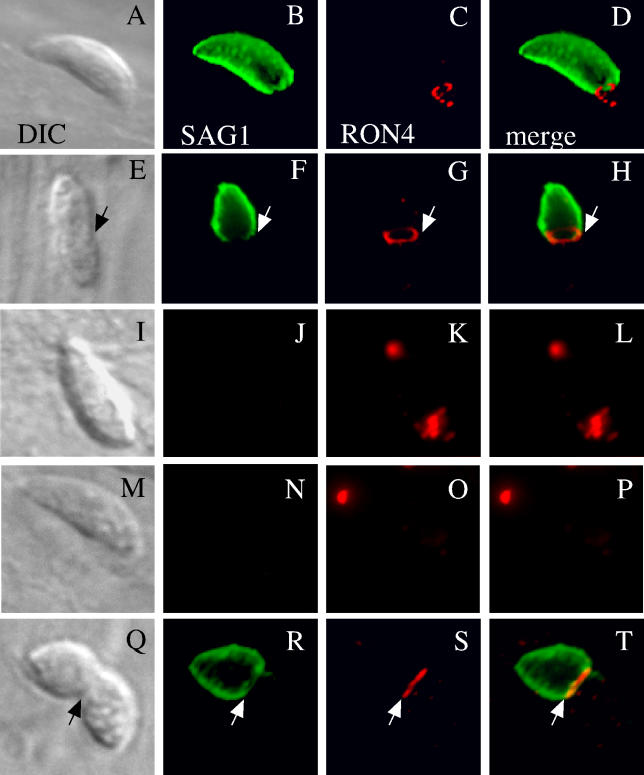
Localization of RON4 During InvasionTachyzoites were allowed to invade following a potassium shift as described in the text. DIC (A, E, I, M, and Q) and deconvolution IIF were then used to image formaldehyde-fixed parasites as described in Figure 3. The images presented are extended focus projections through ten 0.2-μm sections. Prior to detergent permeabilization, SAG1 was detected with the mAb DG52 followed by goat anti-mouse antiserum conjugated to FITC (green) (B, F, J, N, and R). RON4 detection was with rabbit antisera raised to recombinant RON4 and Texas red-conjugated goat-anti-rabbit antibody; this was done after permeabilization by the addition of saponin (C, G, and K) or without such permeabilization (O, S). The merged images are (D, H, L, P, and T). (A–D) represent a parasite that has just begun invasion as indicated by SAG1 staining over about 80% of the parasite. (E–H) show a parasite about halfway in. (I–L) show a parasite that appears to be fully inside (no SAG1 staining) showing small posterior cap of RON4 and apical staining consistent with rhoptry necks. (M–T) show parasites stained without prior permeabilization. (M–P) also show a parasite fully in, whereas (Q–T) show a parasite at about halfway in. The MJ is indicated by an arrow where it is clearly apparent in the DIC image.